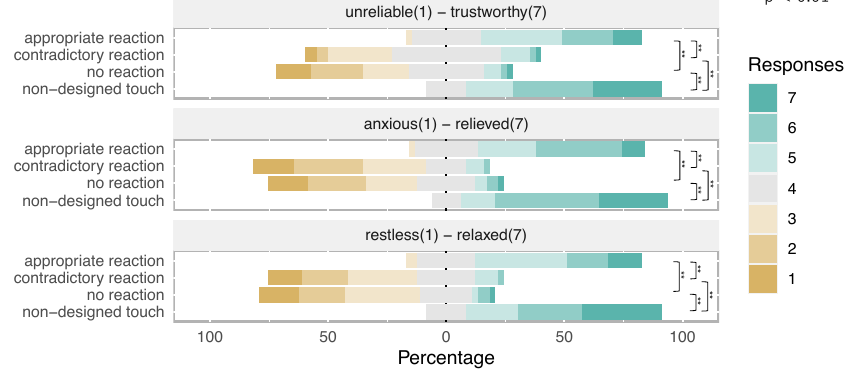
Figure 7. Results of questionnaire responses after each session (3/4): degree of relaxation of the